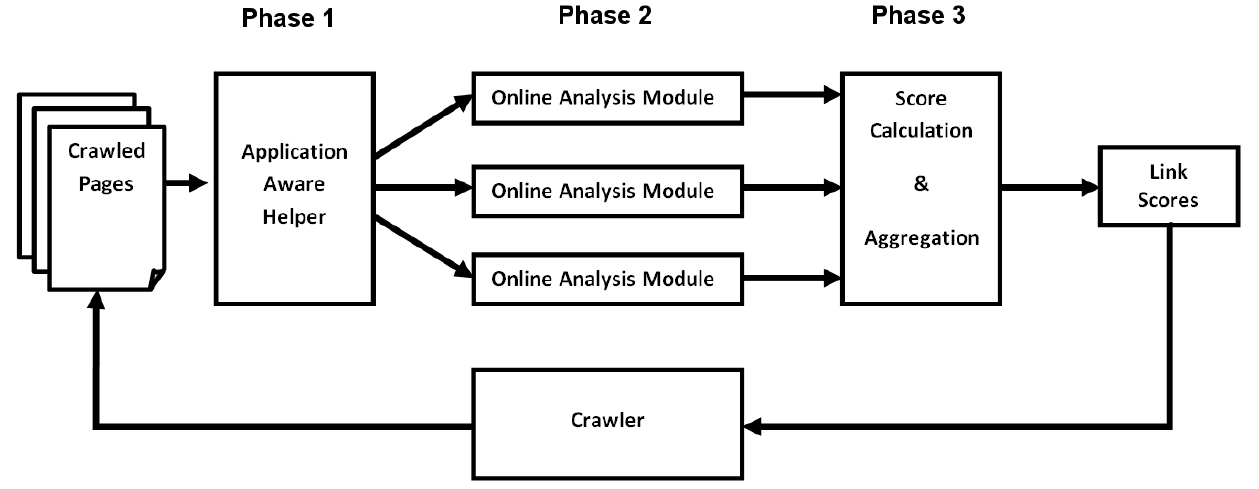
Figure 3. Interaction of online analysis